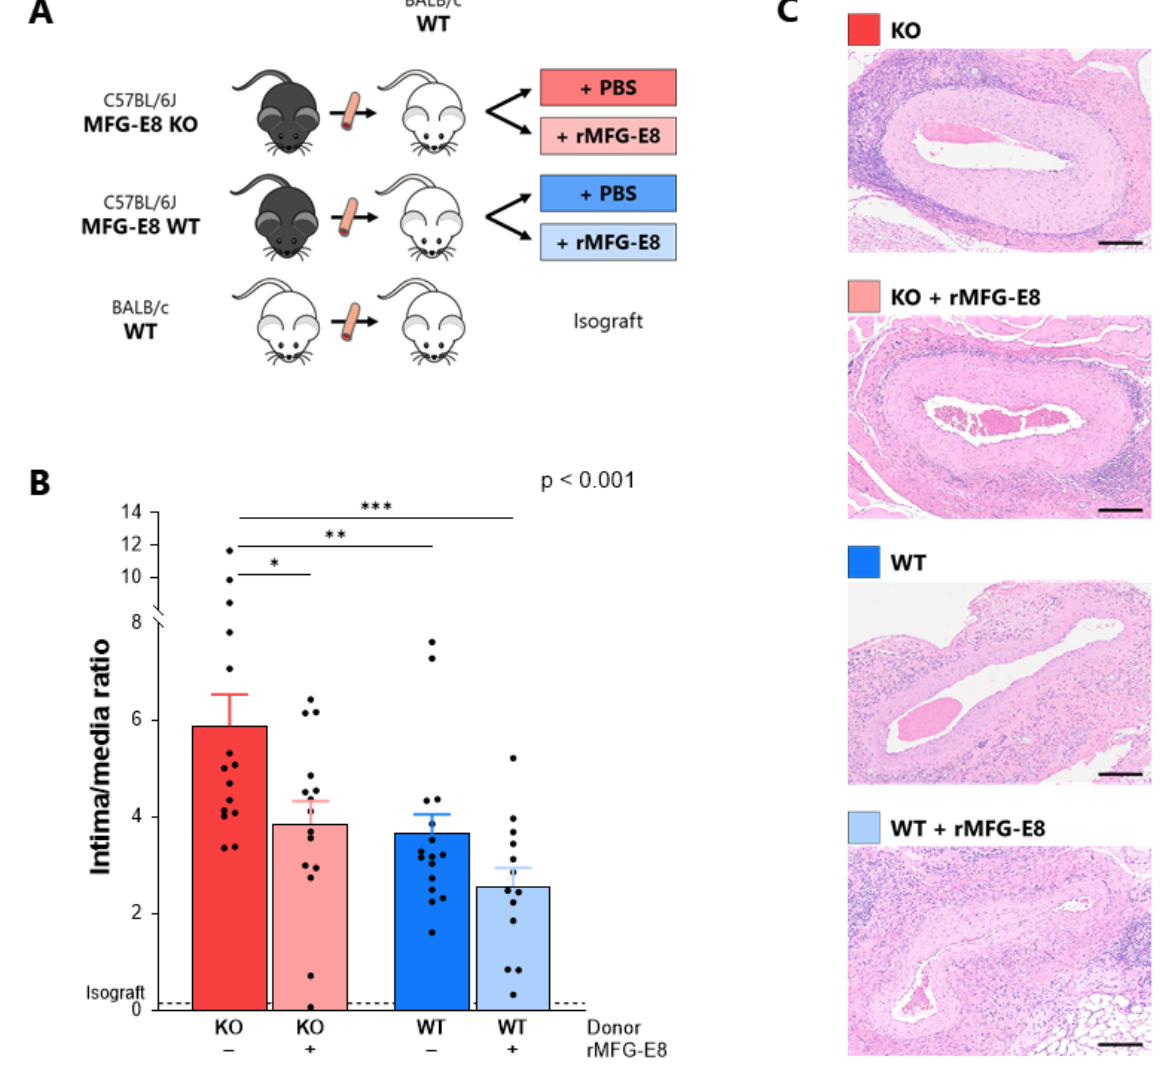
Figure 1. Effect of MFG-E8 on intimal proliferation in a murine model of transplant vasculopathy. ( A ) Murine aortic transplant vasculopathy model. Aorta transplantation procedures were performed between C57BL/6J and BALB/c mice. Mice subsequently received either rMFG-E8 or vehicle (PBS). ( B ) Intimal proliferation (intima/media ratio) within the grafted aorta, assessed by hematoxylin and eosin after 9 weeks. p -Value (upper right corner) indicates the overall ANOVA result. ( C ) Representative section of intimal proliferation in each group. Bars represent 200 μ m. * p < 0.05, ** p < 0.01, * p < 0.001.